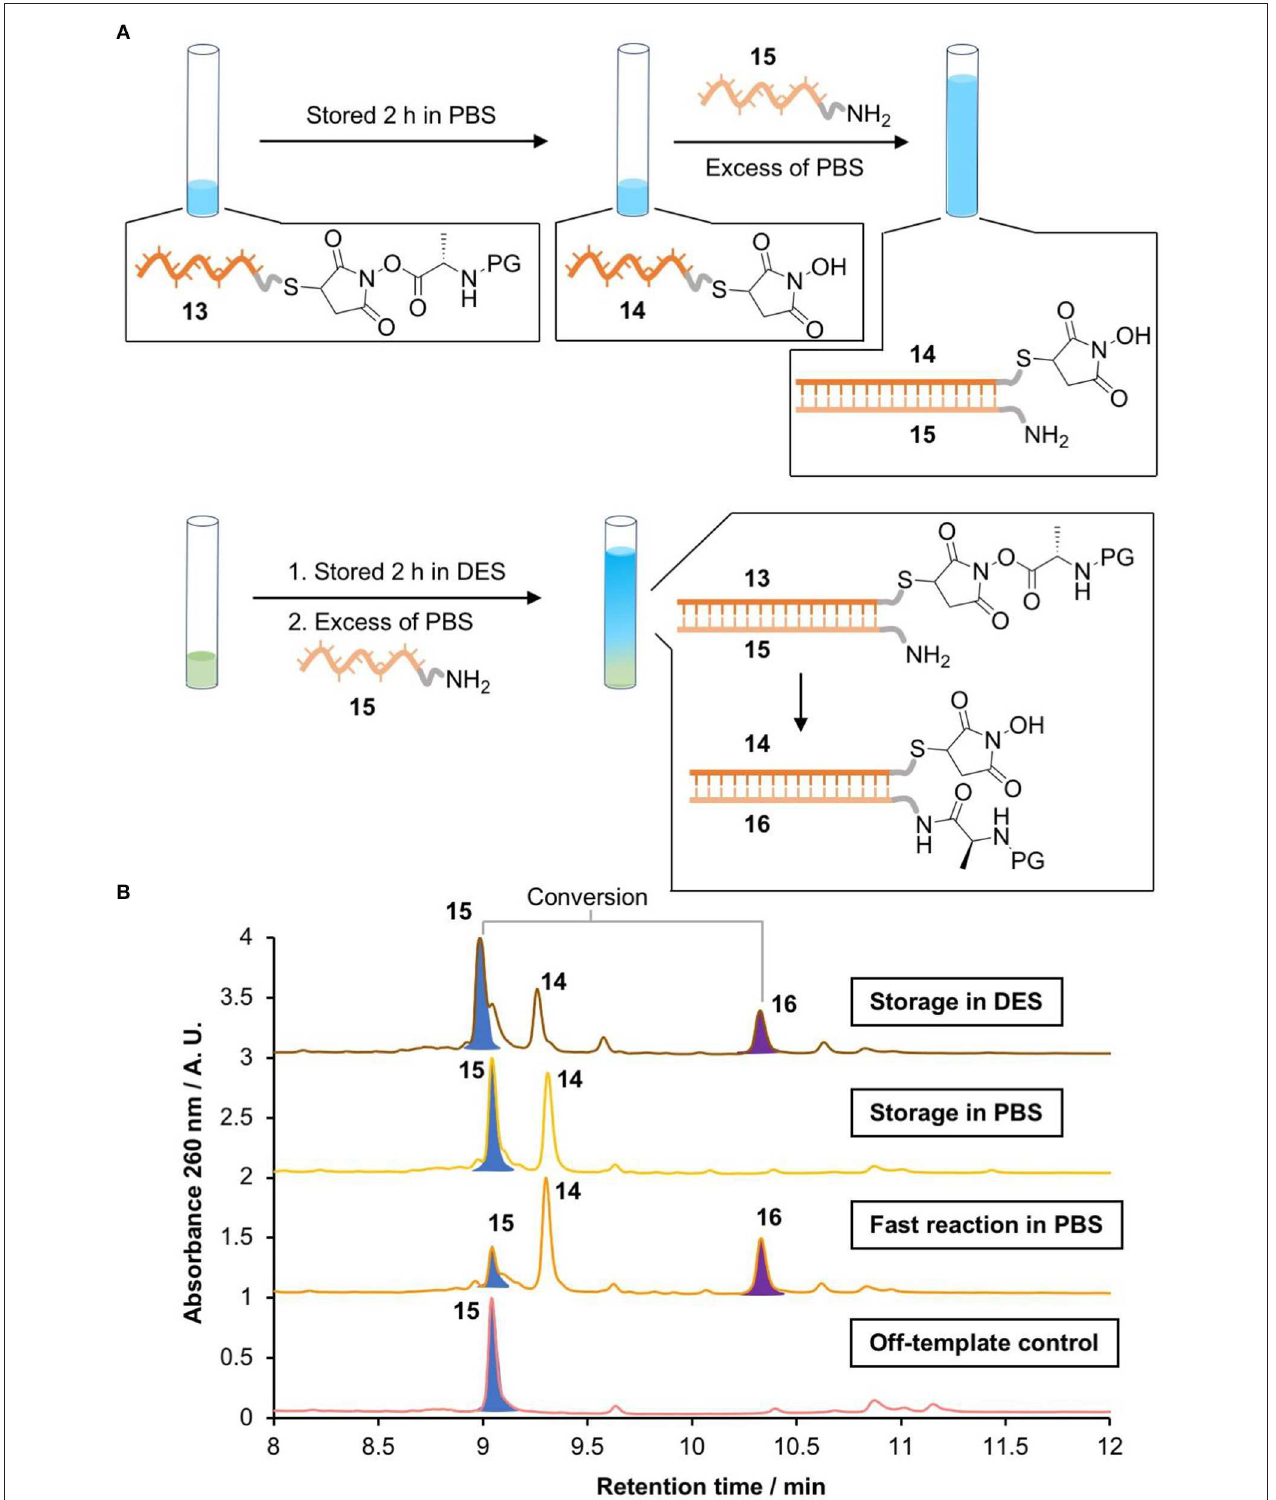
FIGURE 4 | Activating NATS “on demand.” (A) Scheme of the storage of a DNA conjugated activated ester in PBS (0.1M pH 7.0) or Gly 0.07 , followed by DNA-templated peptide bond formation in PBS. (B) LC-MS chromatograms of the products (Waters Xevo-G2-XS). 15 [M] 0 m/z calcd. 10891.855 found 10891.522; 14 [M] 0 m/z calcd. 9558.632 found 9558.581. 16 [M] 0 m/z calcd. 11201.935 found 11201.489.